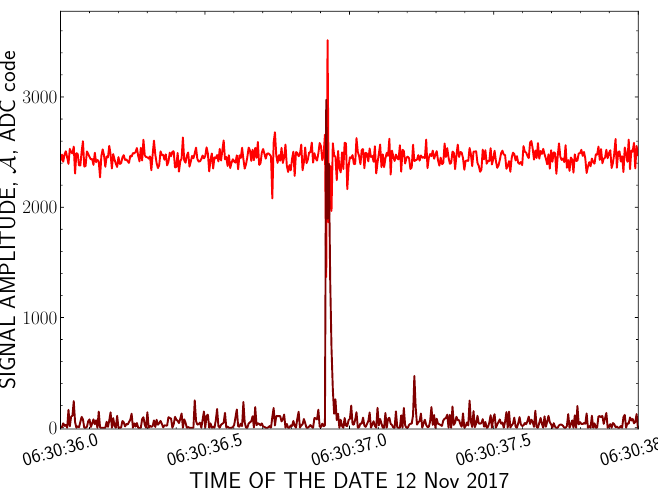
Figure 1. Sample record of the acoustic detector data: the upper distribution is the original micro- phone signal, while the lower one is its smoothed envelope detected by the low-pass filter. The short-time peaks are seen in the envelope